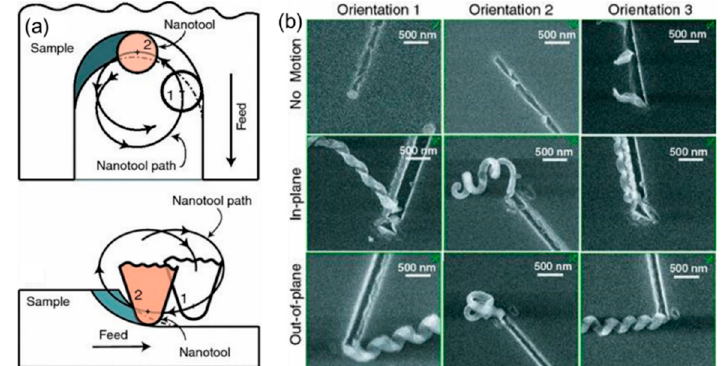
Figure 7. The schematic diagram of nanomilling: ( a ) the trajectory of the tip when scratching sample, ( b ) the scanning electron micrographs (SEMs) of nanochannels fabricated by nanomilling [85] . Li et al. [86] also used the nanomilling approach to scratch on a PMMA bulk sample. In their